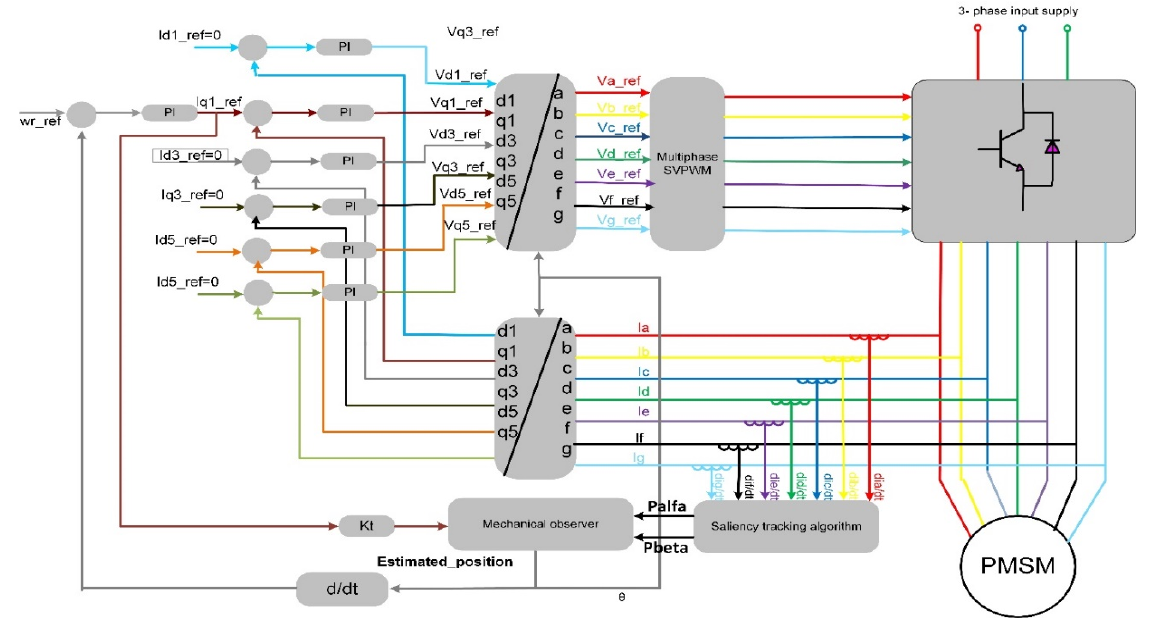
Figure 14. Speed control structure for the five-phase inverter PMSM drive post the failure in the speed sensor.